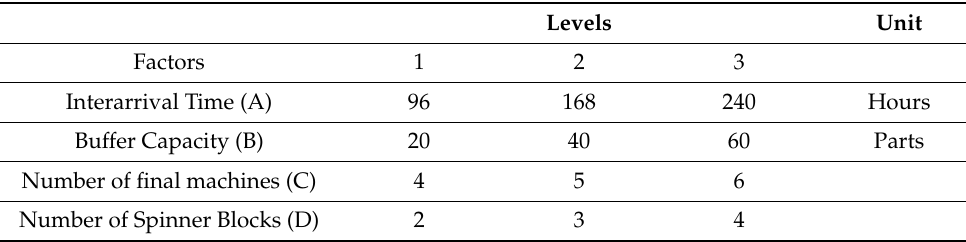
Table 5. Factor levels